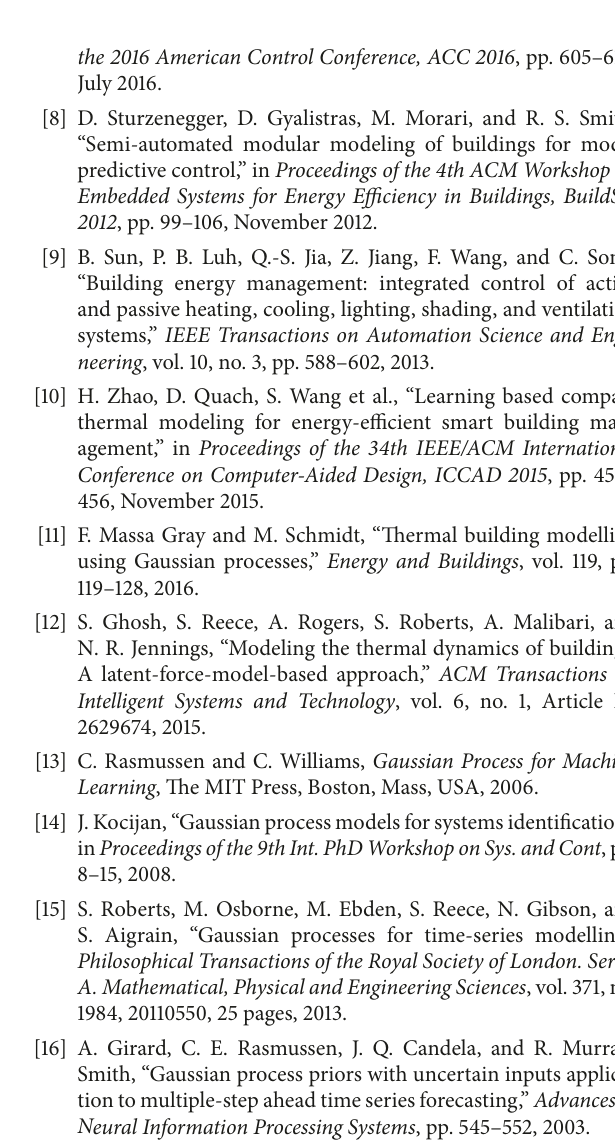
Figure 21: Evaluating model learning efficiency and performance of the north zone in the five-zone building using different training dataset sizes, with a comparison between the full GP model and the SHS model. (a) Average learning time. (b) Prediction error statistics using